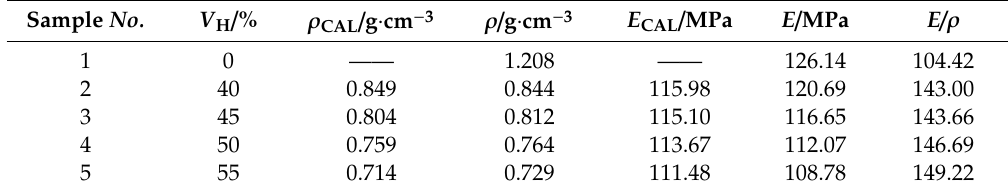
Table 5. The comprehensive properties of cured AG-80 / m-XDA system ( phr = 26) and AG-80 epoxy resin-based buoyancy materials with different volume fraction ( V H = 40%, 45%, 50%, and 55%) of hollow glass microspheres (HGM) .